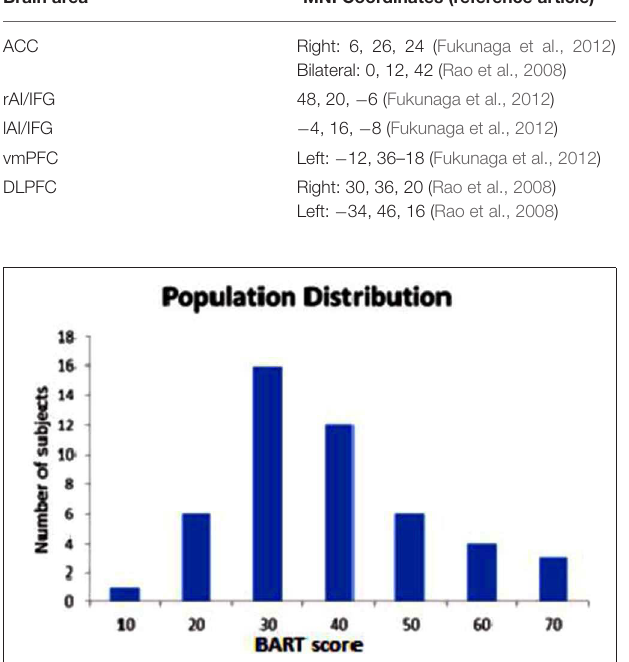
FIGURE 2 | Measured BART score of 48 participants. (Mean = 33.50, Standard Deviation = 13.19, variance = 174.12) The frequency histogram shows the number of participants as a function of BART score.